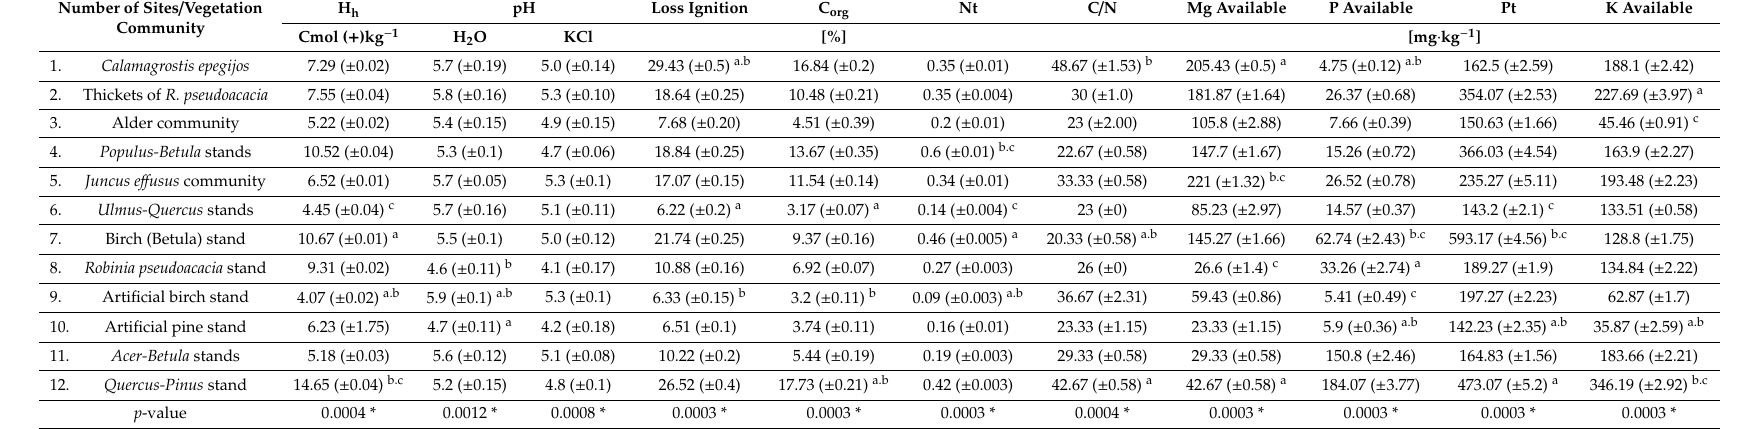
Table 3. Soil properties under di ff erent vegetation communities in the post mining